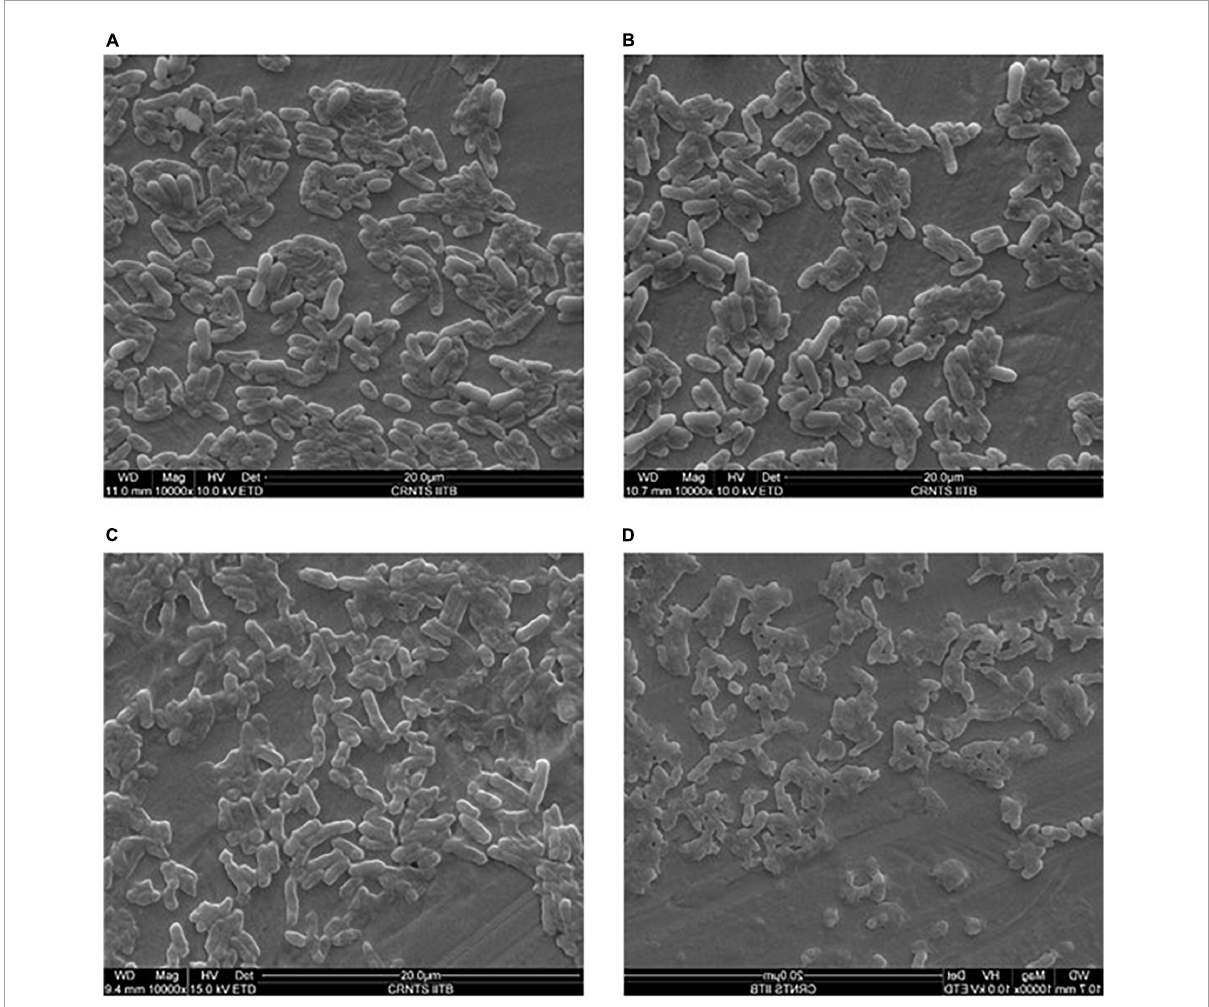
FIGURE6 Scanning electron micrograph of bacterial cells under UV radiation and the effect of carotenoid extract on protecting cells from radiation. Methylobacter sp N39 cells without UV exposure (A) ; Methylobacter sp N39 cells after 15 min of UV exposure. Cells survived UV radiation without any apparent disruption of cellular structure (B) . E. coli cells exposed to UV C radiation for 5 min (C) . The cellular structure damaged exhibiting deformed cells due to UV radiation; (D) E. coli cells treated with crude carotenoid after exposure to UV C radiations for 5 min. E. coli cells were protected from UV radiation by the carotenoid extract of Methylobacter sp N39